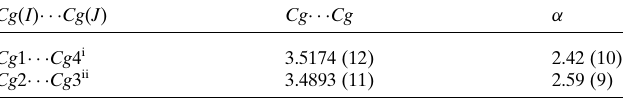
Table 2 Analysis of (cid:4) – (cid:4) interactions (A˚ , (cid:3) ). (cid:5) is the dihedral angle between planes I and J. Cg 1, Cg 2, Cg 3 and Cg 4 are the centroids of the N1–N3/C1–C3, N4–N6/C4–C6, N7–N9/C7–C9 and N10–N12/ C10–C12 rings, respectively.